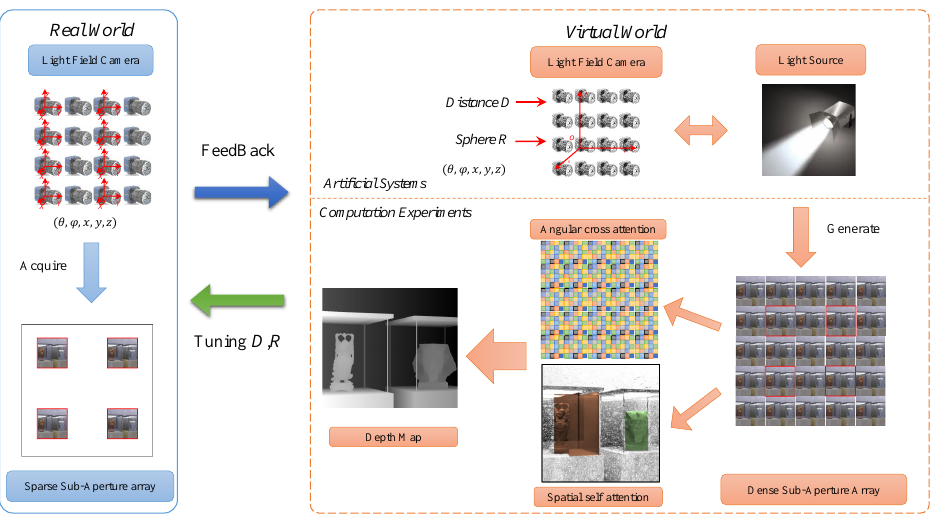
Figure 2. Framework of ACP based light field